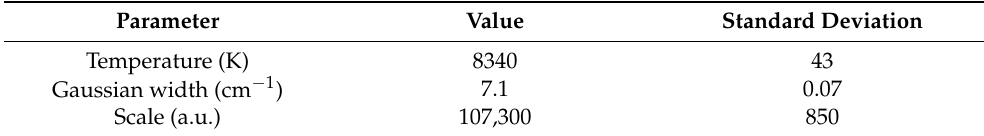
Table 8. PGOPHER fitting parameters for the 0.11 nm data and